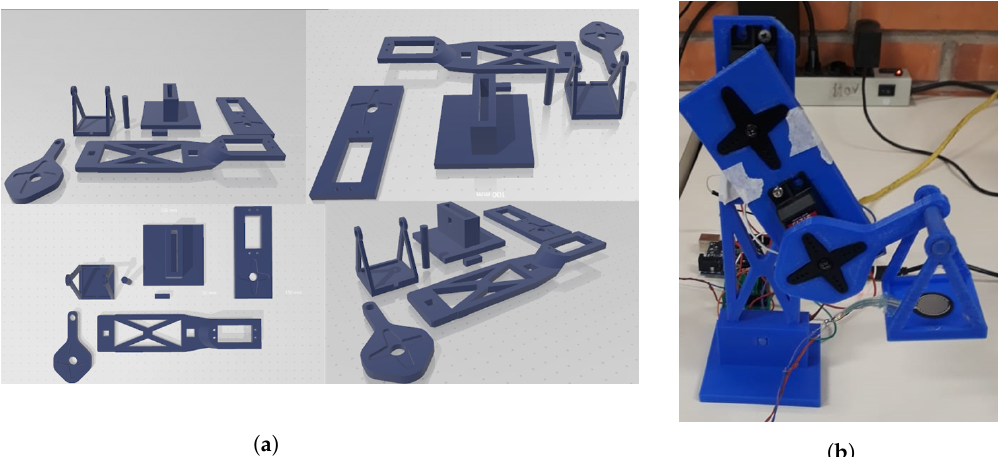
Figure 7. The proof of concept: ( a ) 3D modeling; and ( b ) physical